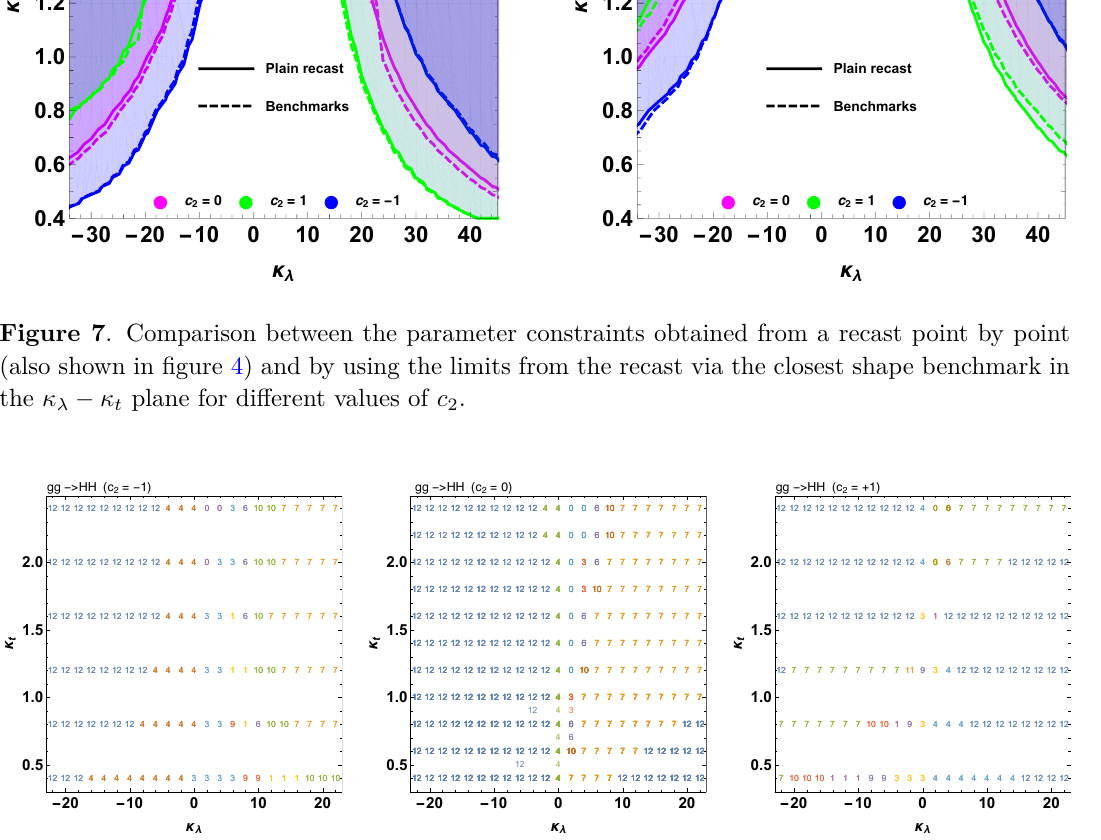
specific model without the need of expensive MC simulations or recast. This usage would hold for the case of including further BSM effects such as the inclusion of additional EFT operators (for example, the chromomagnetic term [44]) or the departure from the EFT framework towards explicit inclusion of particles in the loops (for example [45, 46]). As an example, in figure 7 we show the comparison between the constraints estimated from the limits derived via benchmarks and the explicit result of the recast described in the last section for a scan in the κ − κ plane for different values of c (also shown in figure 4). For t 2 λ completeness, in figure 8 we also provide the mapping between shapes and shape bench- marks as computed via eq. (5.1). It is clear that for different values of c the population 2 of shape benchmarks changes in the κ − κ t λ